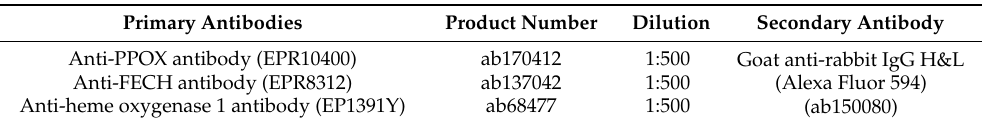
Table 1. Antibodies used in the immunofluorescence experiment. All antibodies were purchased from Abcam (Cambridge,